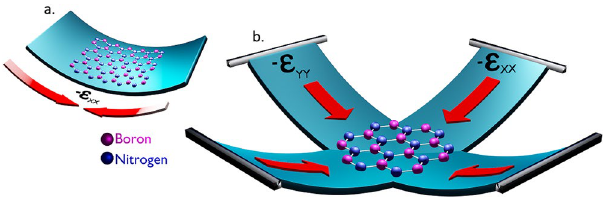
Figure 4. Schematic illustration of negative biaxial strain inducement to hBN film. The hBN film is transferred to PC beam arranged in cruciform structure to induce biaxial strain. All the edges are bent upwards to induce negative biaxial strain which leads to overall shrinking of material. ( a ) Shrinking (compressive) force induced towards only tensor xx component will leads to negative uniaxial strain. ( b ) As similar to ( a ), if compressive force is induced in both tensor xx and yy components then it will lead to negative biaxial strain.